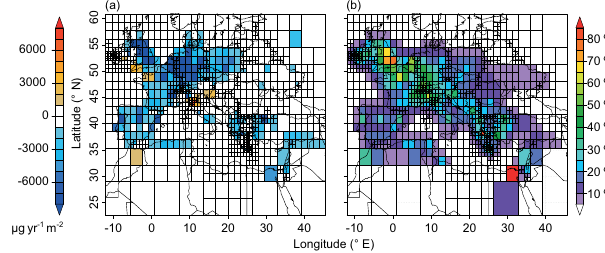
Figure 5. (a) Emissions difference (posterior – prior) of the BASE inversion of HFC-134a. (b) Relative reduction of the a posteriori uncertainty compared to the a priori uncertainties of